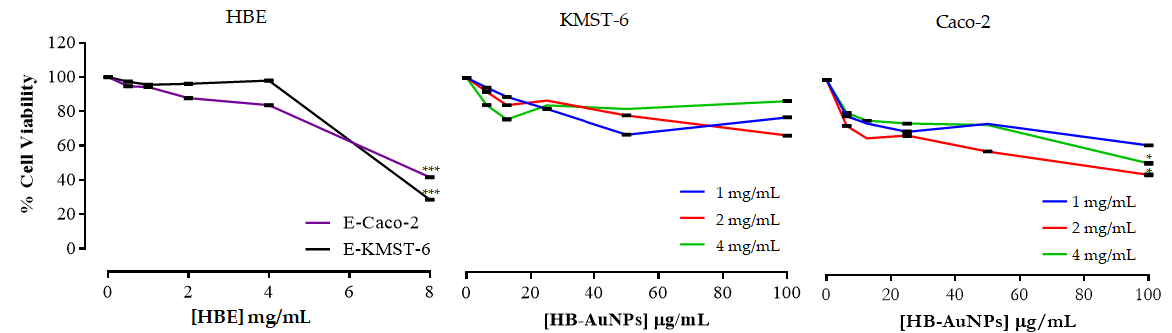
Figure 6. Cytotoxicity of HBE and HB-AuNPs on KMST-6 and Caco-2 cells. p ≤ 0.05 was considered as statis- tical significant for untreated vs. treated samples, * p ≤ 0.05 , *** p ≤ 0.001. as statistical significant for untreated vs. treated samples, * p ≤ 0.05, *** p ≤